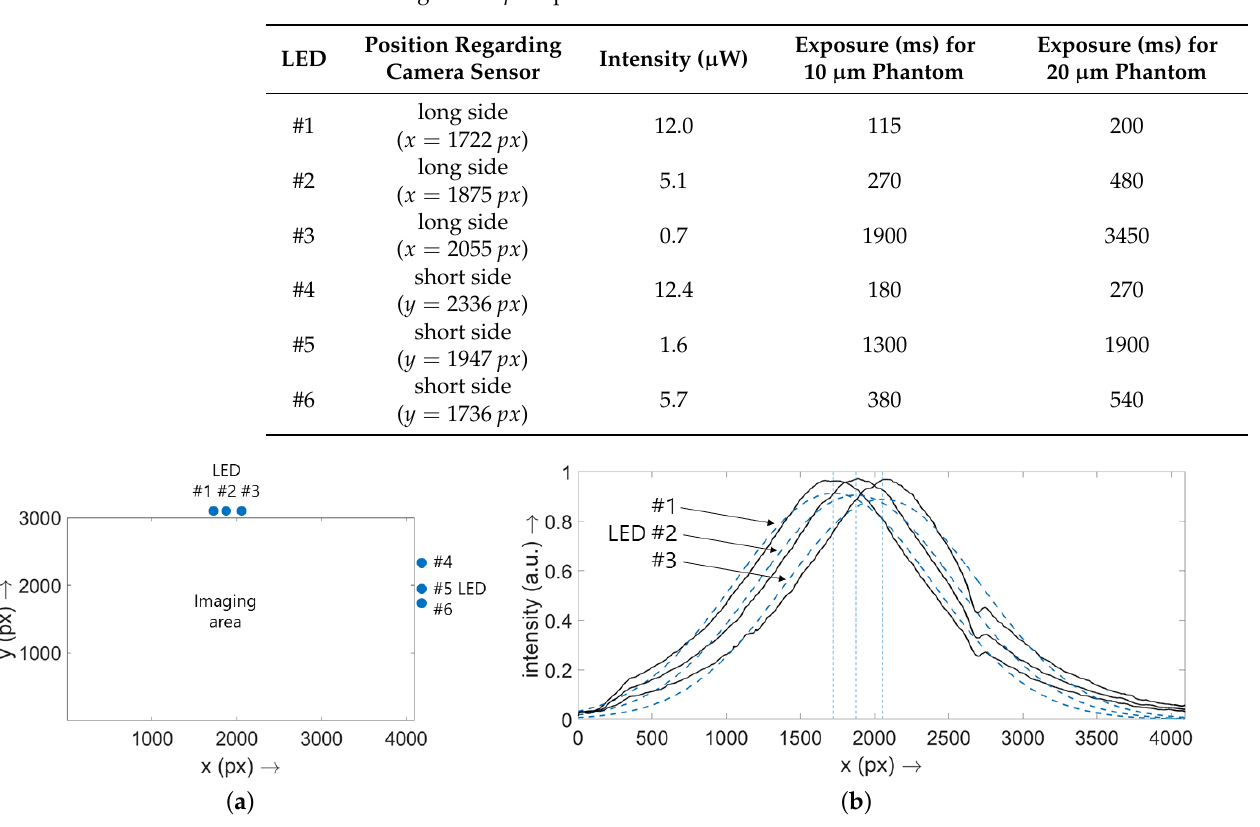
Table 1. Technical and constructional data of the illumination used. The exposure time refers to the camera, not to the duration that the LEDs were switched on. The position of the LEDs is further illustrated in Figure 2a. px = pixel.